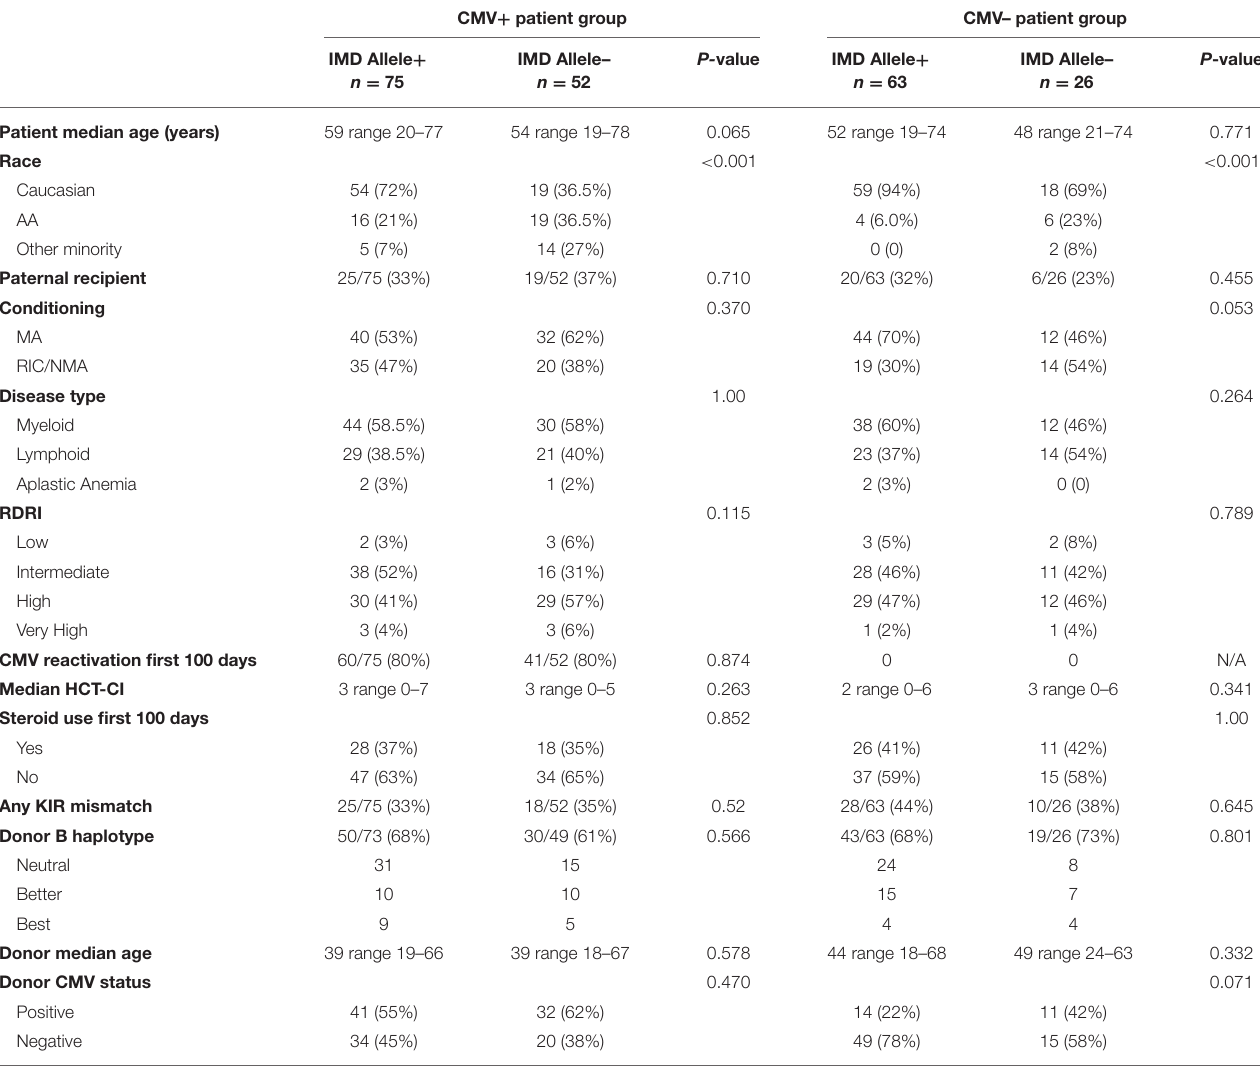
TABLE 1 | Associations of confounders with CMV IMD